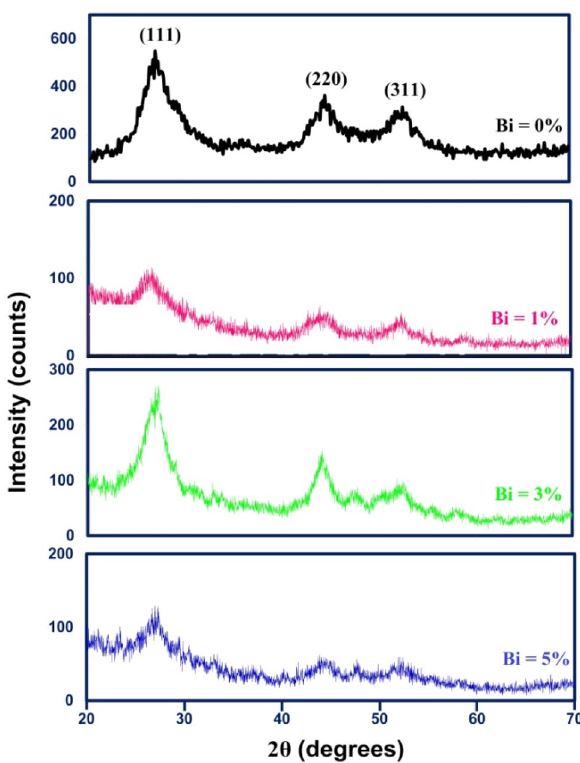
Fig. 1 XRD spectra of Cd